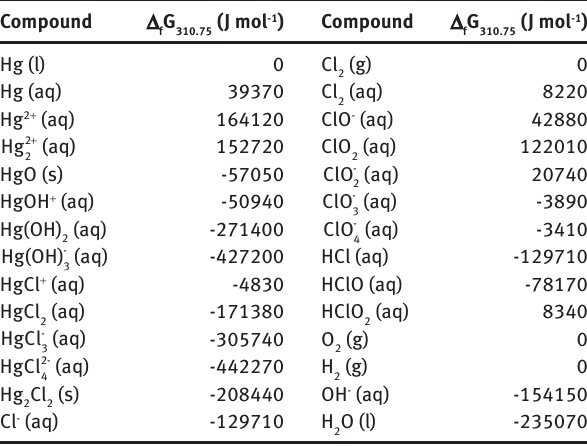
Table 1: The Gibbs energies of formation of compounds in + - 2 -ClH -Hg Osystem at 310.75 K and 1 2 2